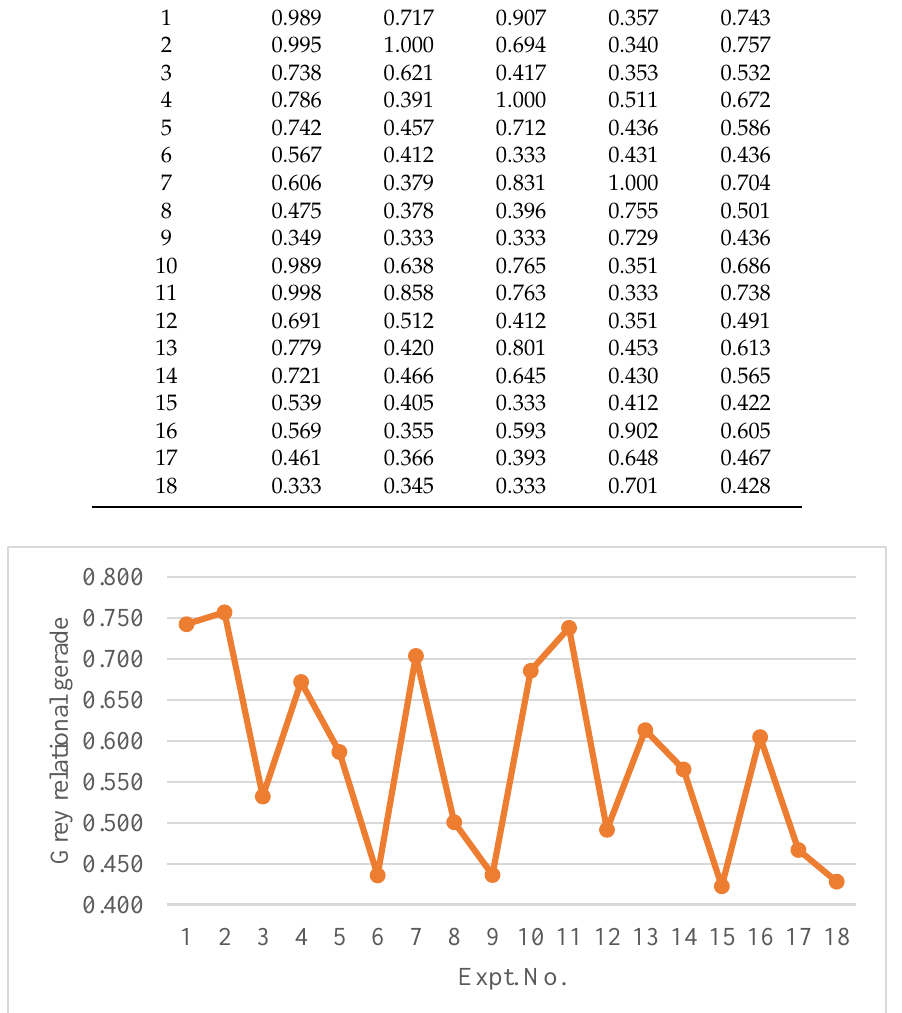
Table 6. The grey relational coefficients and grade for each experimental run. Expt. No.